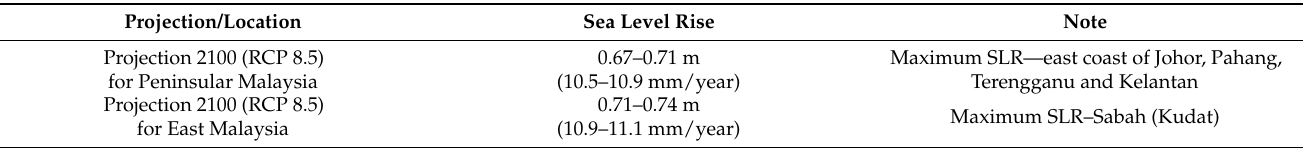
Table 4. Projection of sea-level rise in Malaysia for * RCP 8.5 in year 2100 [133]. Reproduced from Report on Impact of Climate Change: Sea Level Rise Projection in Malaysia, 2017; published by National Water Research Institute of Malaysia.